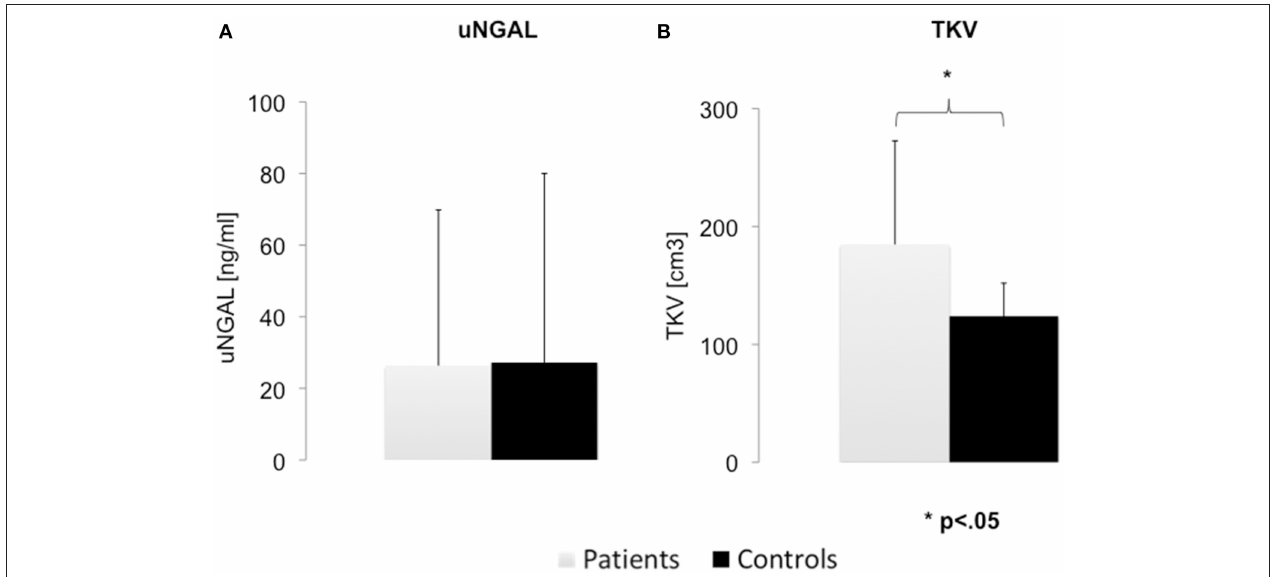
FIGURE 1 | Difference in urinary NGAL and Total Kidney Volume between groups. (A) No differences in urinary NGAL (uNGAL) were observed between ADPKD patients and the gender and age matched control group. (B) Total kidney volume (TKV) was significantly higher in patients. Error bars show standard error of the mean.